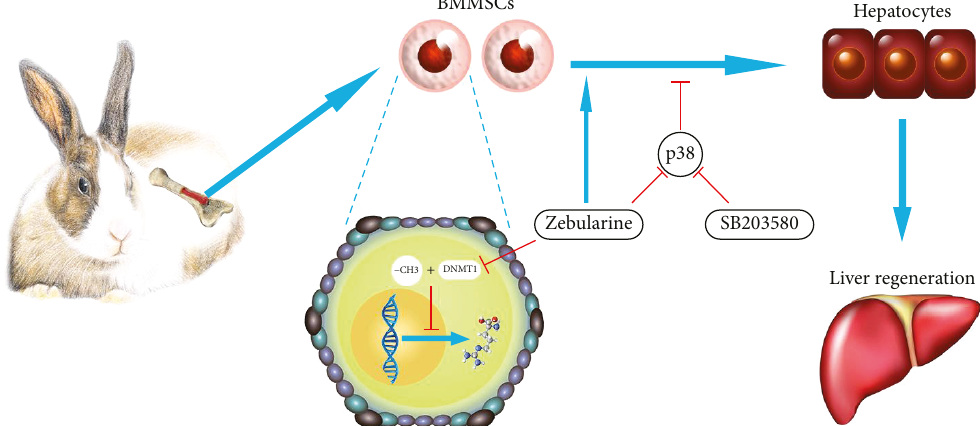
Figure 7: Graphical abstract. The increase in the level of DNMT1 and phosphorylated p38 in BMMSCs was restrained by zebularine. Zebularine leads to remarkable increment in hepatic di ff erentiation of BMMSCs, partly through regulation of HGF-induced p38